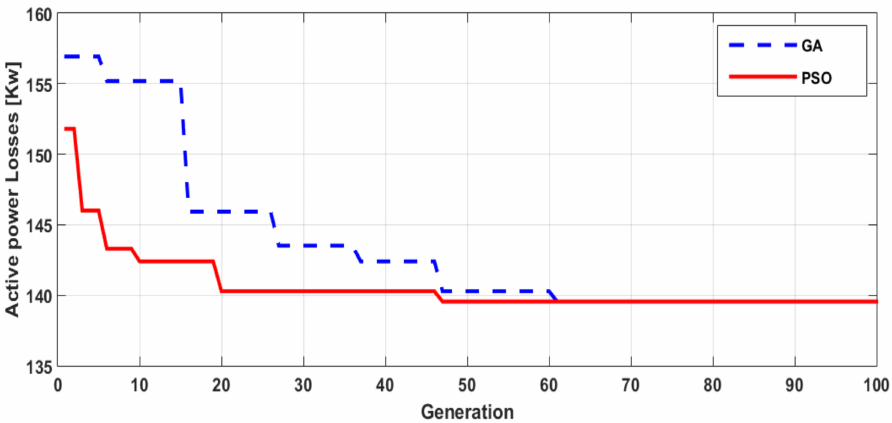
Figure 12. GA and PSO convergence characteristic for the minimization of the active power losses cri-